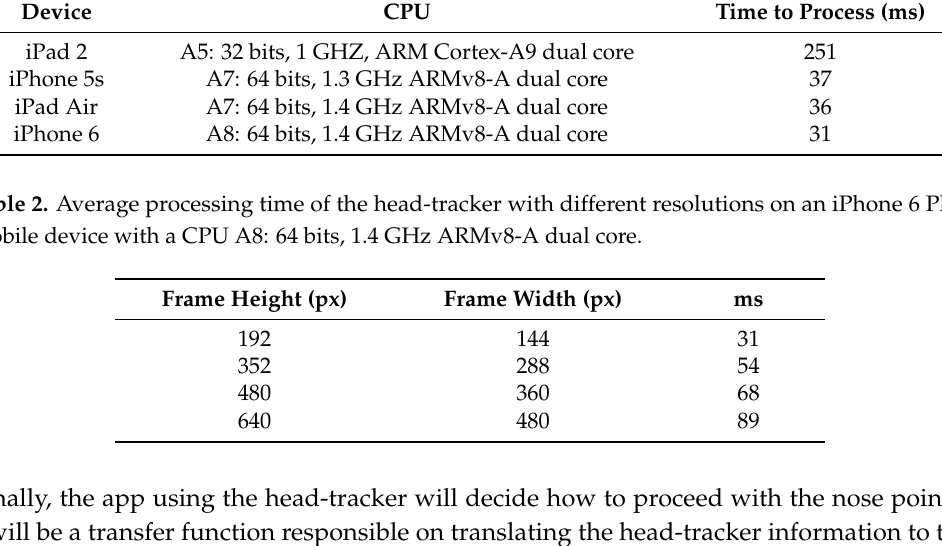
Table 1. Average processing time of the head-tracker for different mobile devices.